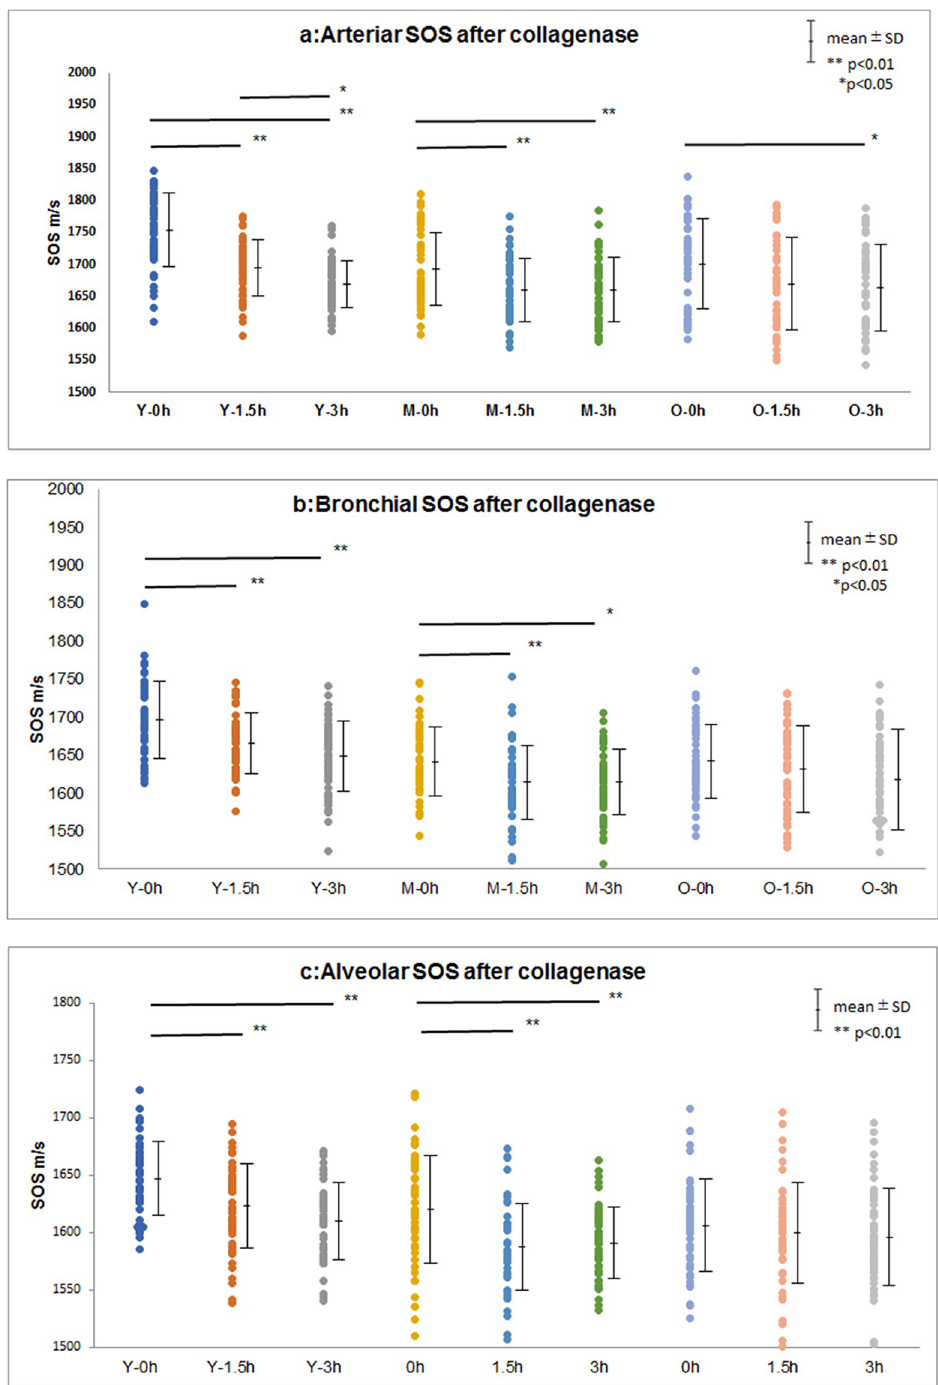
Fig 9. Change in SOS values over time after collagenase treatment among young, middle-aged, and old groups. (a) Arteriolar SOS, (b) bronchiolar SOS, and (c) alveolar SOS. Dot plots of mean SOS values ( ± standard deviation) are shown. Young and middle-aged lungs show significant reduction in SOS values 1.5 h and 3 h after digestion. However, old lungs show no considerable reduction in SOS values, except for the SOS values of arterioles after 3 h. Y, young; M, middle-aged; O,